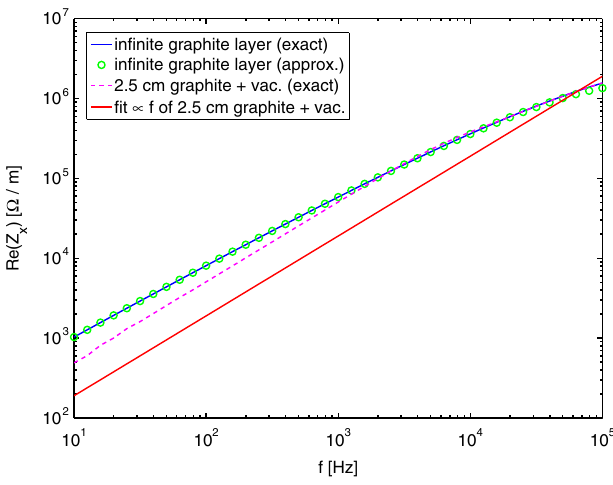
FIG. 5. (Color) Real part of the transverse wall impedance at low frequencies for the case of an LHC collimator with b ¼ 2 mm . We compare the exact expression for an infinitely thick graphite layer from Eq. (20) (solid blue line), its approximation by Eq. (25) (green circles), the exact expression for a 2.5 cm graphite layer surrounded by vacuum (dashed magenta line), and its fit by an expression proportional to f (solid red line). The parameters are those of Fig.